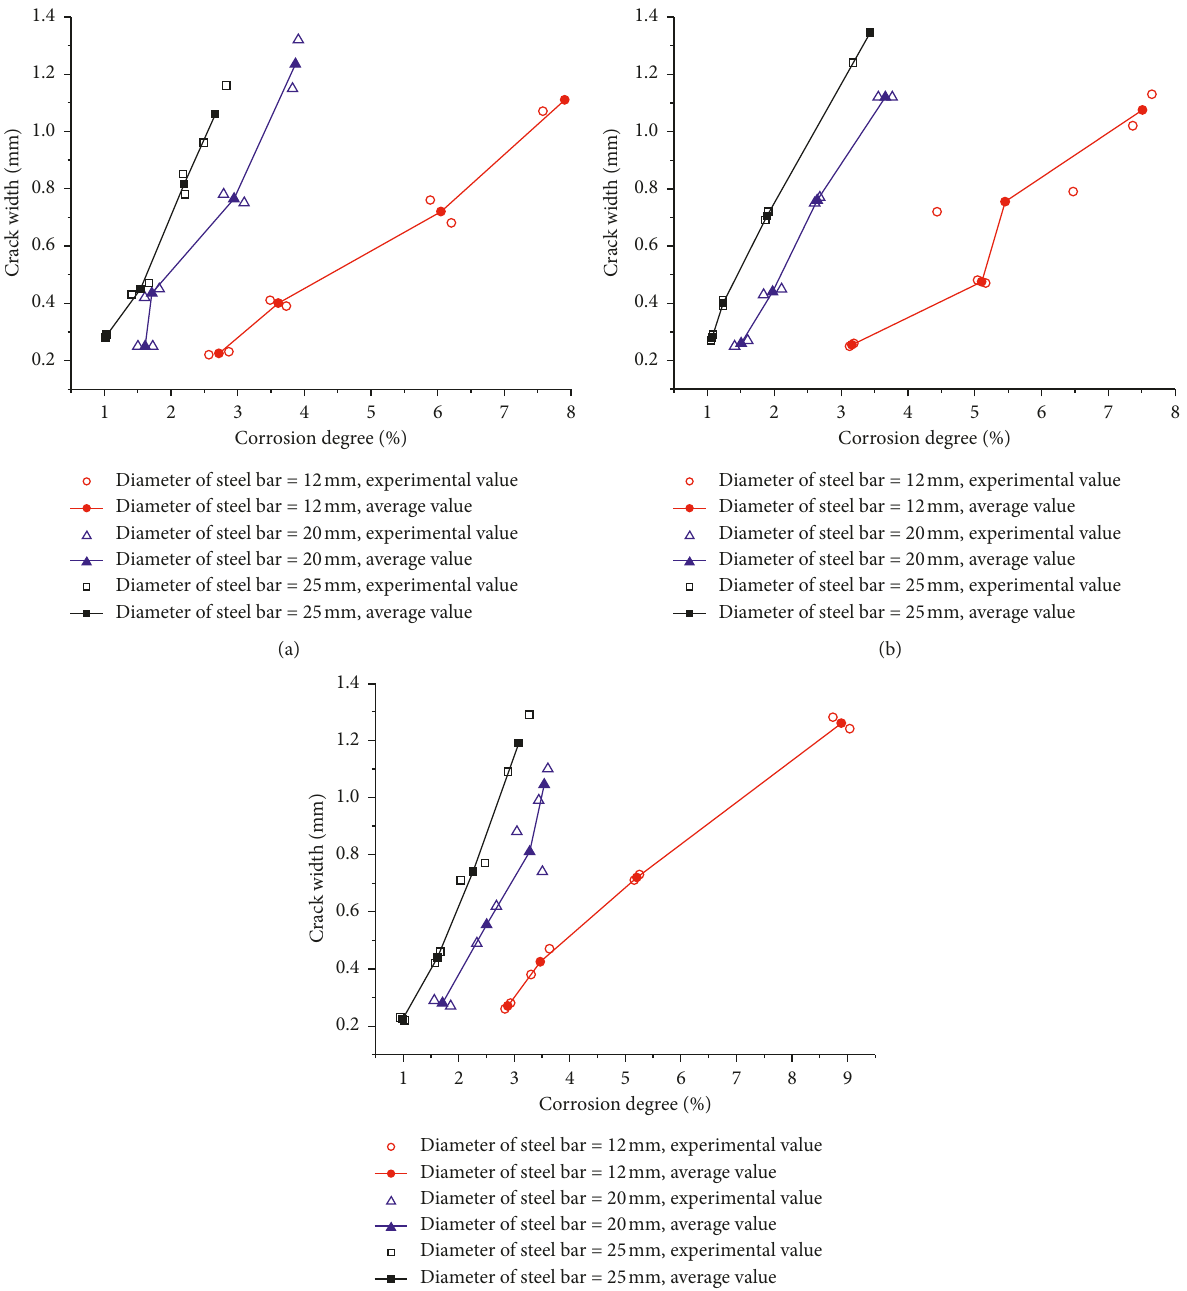
Figure 13: Effect of the diameter of steel bar on the relationship between cracking width and steel corrosion degree for different thickness of concrete covers: (a) C � 30 mm; (b) C � 40mm; (c) C �